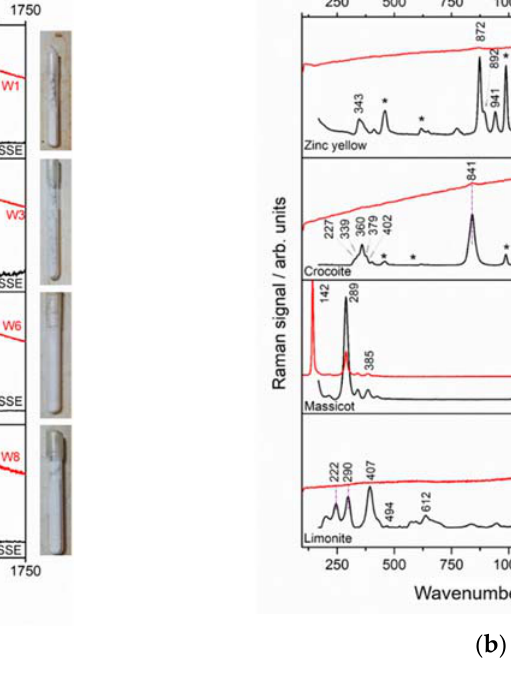
Figure 6. pSSE (black line) and dispersive (red line) RS of examined ( a ) white (top ‐ to ‐ bottom: calcite, hydrozincite, barite, gypsum); ( b ) yellow (top ‐ to ‐ bottom: zinc yellow, crocoite, massicot + lead white, limonite) materials. The considered spectral range is 170–1750 cm − 1 . * Indicates the bands assigned to barite.